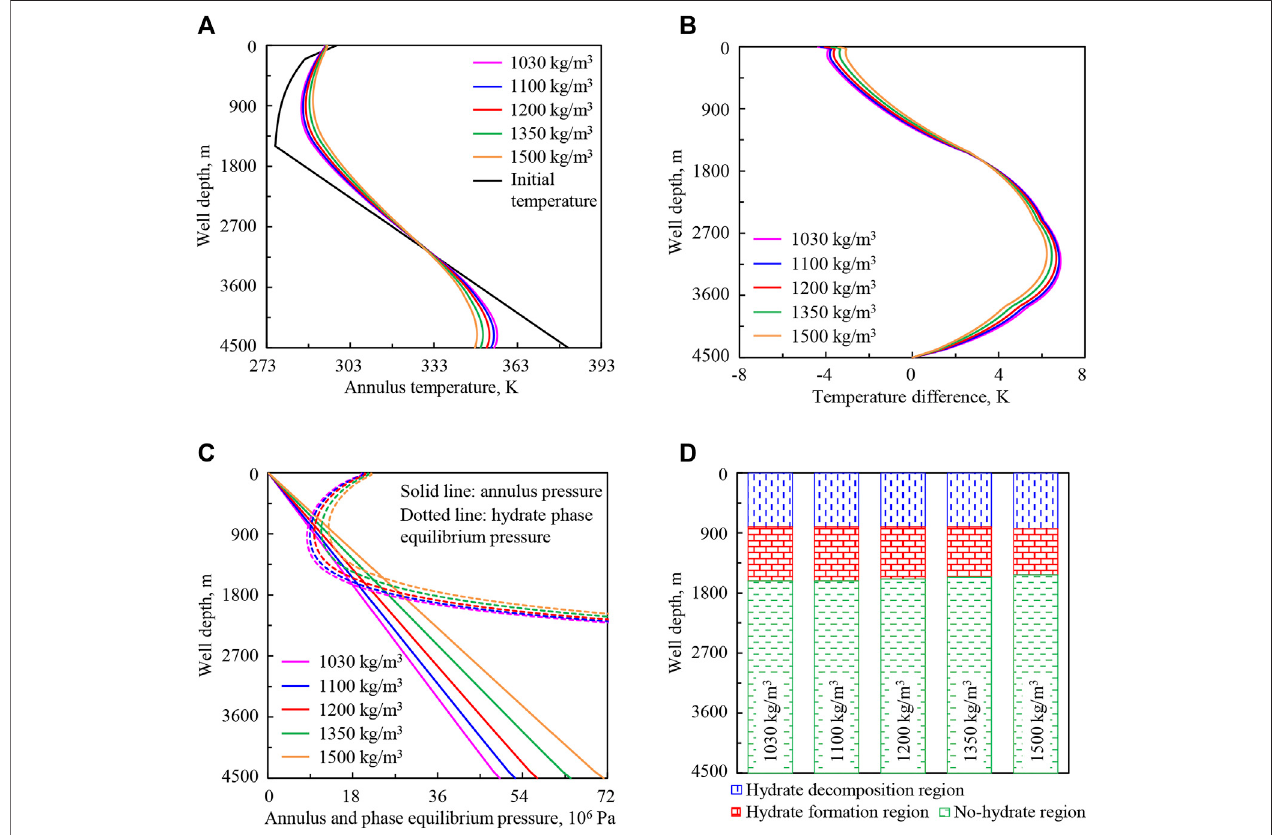
FIGURE 8 | Variation regularities of wellbore temperature fi eld, pressure fi eld, and hydrate formation region in deep-water drilling under different drilling fl uid densities: (A) annulus temperature, (B) temperature difference between the drilling fl uid in the annulus and in the drill string, (C) annulus pressure and phase equilibrium pressure, (D) hydrate formation